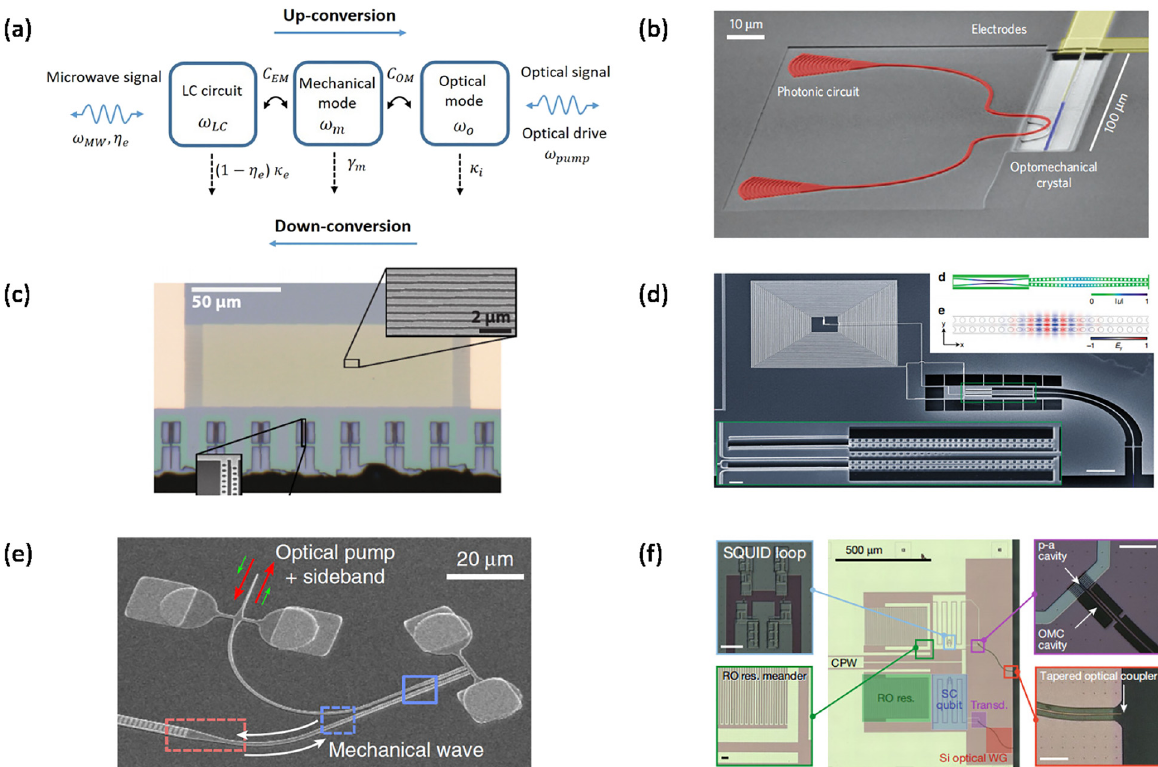
Figure 4: Applications to quantum information processing. (a) Block diagram of the piezo-optomechanical transduction process, indicating the electrical, mechanical, and optical modes, relevant frequencies ( 𝜔 cooperativities ( C , C ), and electrical and optical coupling efficiencies ( 𝜂 EM OM view) showing the mechanically suspended AlN optomechanical crystal (blue) with aluminum electrodes (yellow) and the AlN photonic circuit (red, rib waveguide and grating couplers) [92]. (c) Microscope image of the microwave-to-optics transducer devices: The structures are comprised an interdigital transducer (IDT, in gold, cf. upper inset), which spans several optomechanical devices for ease of fabrication [93]. (d) Silicon photonic microwave-to-optics converter. Scanning electron micrograph (SEM) of the device showing the microwave lumped element resonator with an inductively coupled feed line, the photonic crystal cavity, and the optical coupling waveguide fabricated on a fully suspended 220 nm thick silicon-on-insulator device layer [94]. (e) SEM of one piezo-optomechanical transducer [19]. (f) Electrical circuit representation of the integrated qubit and transducer device